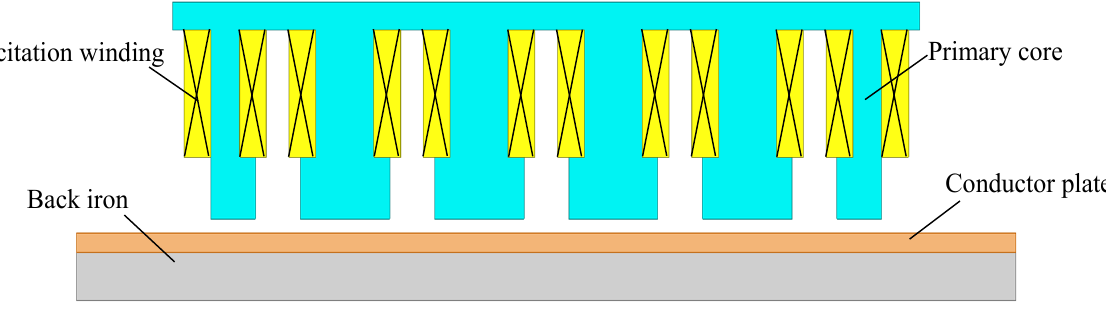
Figure 17. Structure of the electric excitation linear eddy current